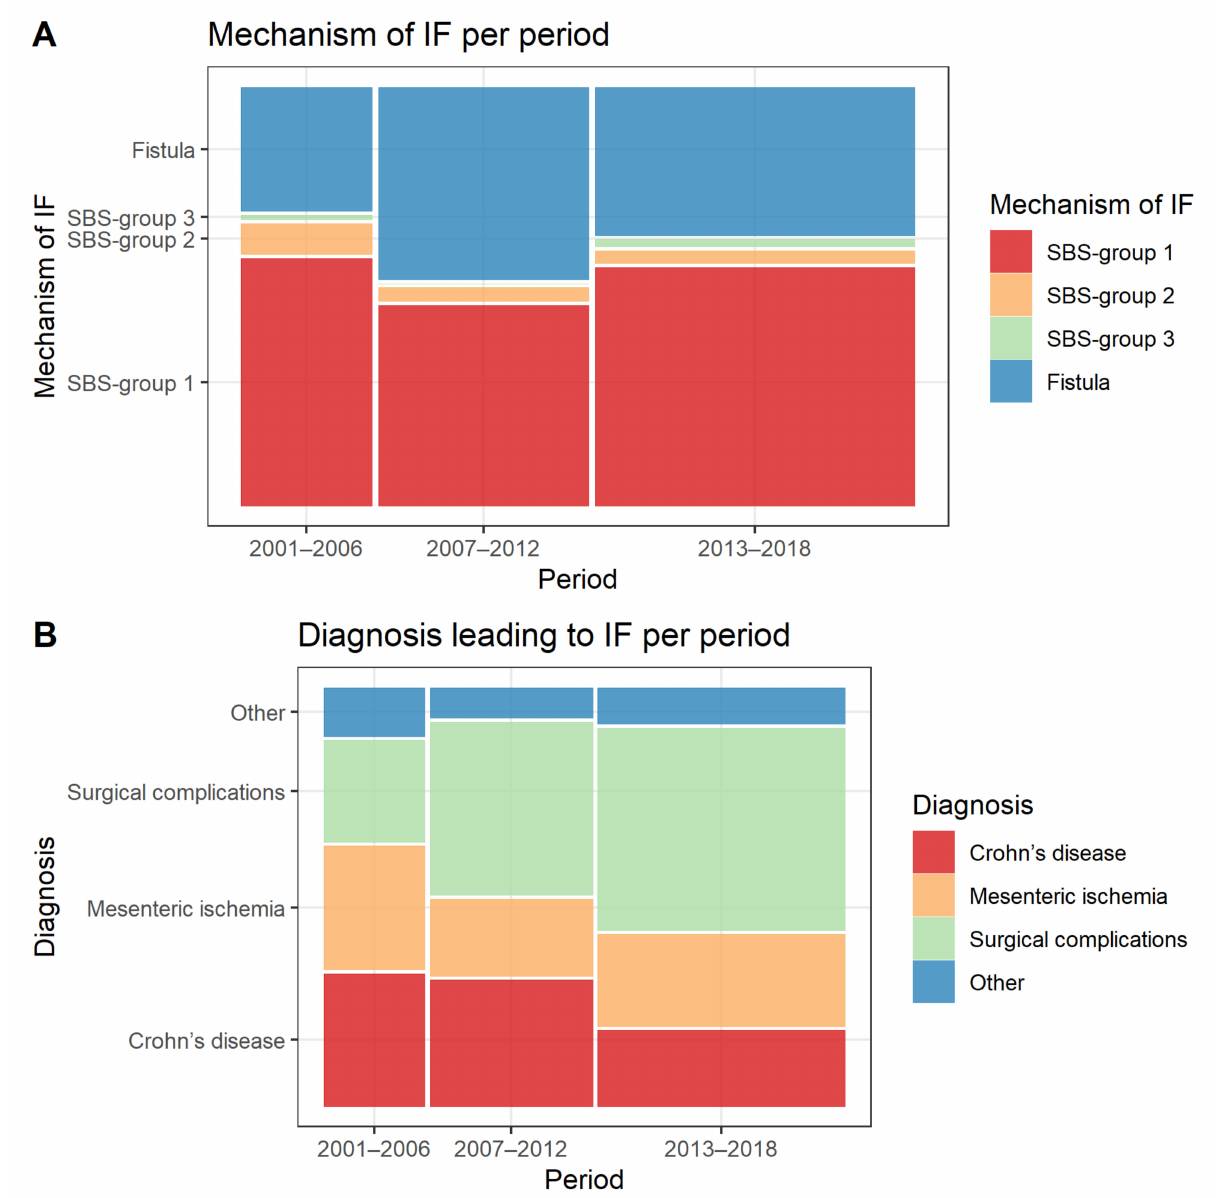
Figure 1. Changes in ( A ) mechanism and ( B ) diagnosis leading to IF over the study period, presented on a mosaic plot where the size of the squares represents the proportion of all included patients. IF, intestinal failure; SBS, Short bowel